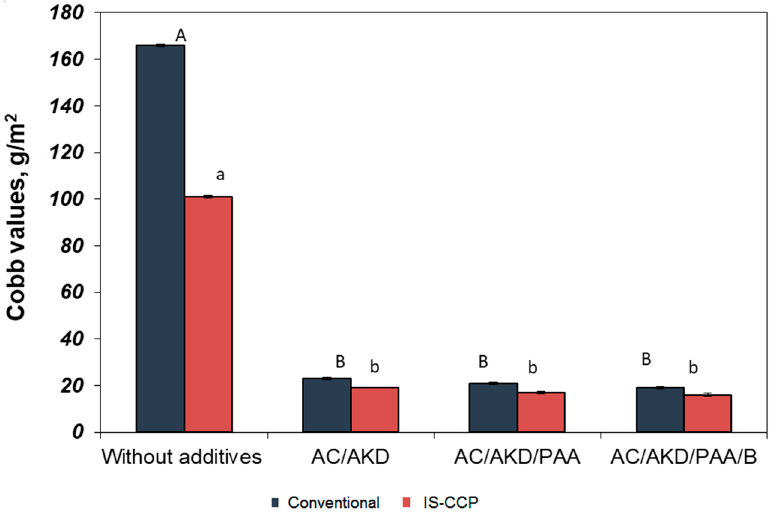
Figure 7. Cobb values for different additive systems in relation to paper composition (different letters within the same method—small letters for conventional and capitals for IS-CCP designate statistical difference, p < 0.05).